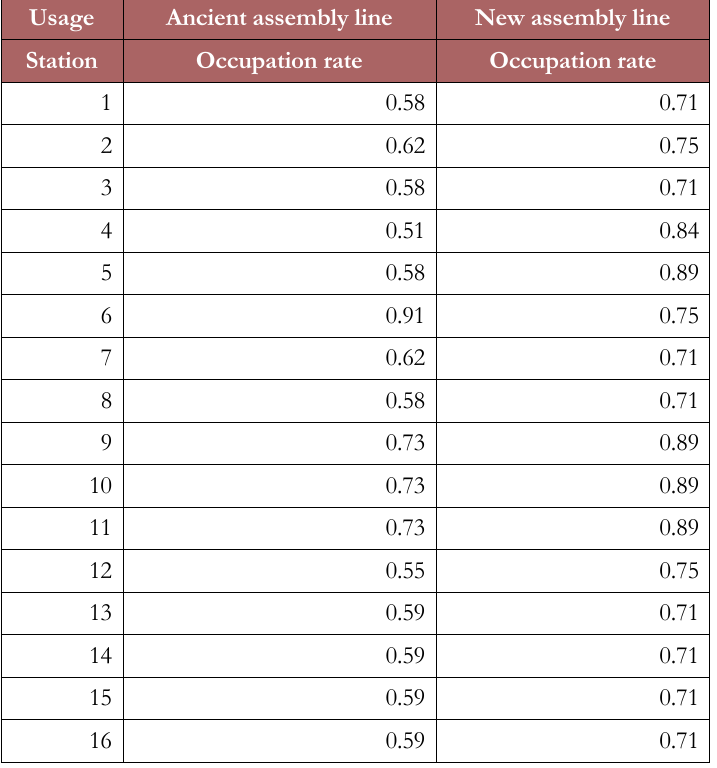
Table 8. The occupation rate of